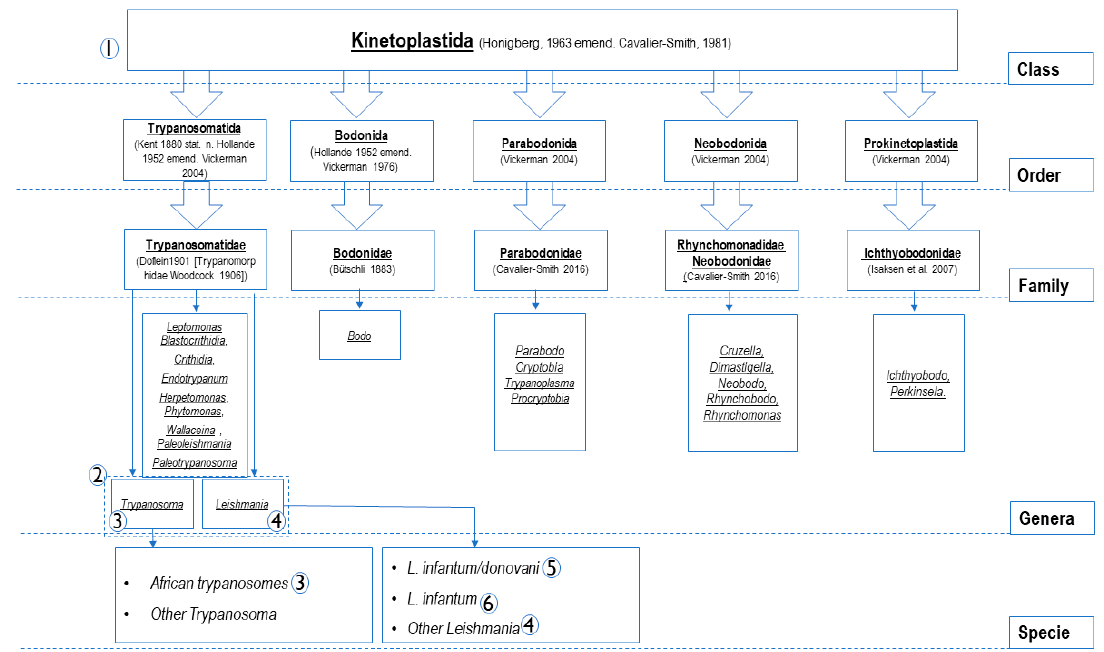
Figure 1. Members belonging to Kinetoplastida class (according to Sina M et al., 2012) [30] and specificity-based principles of the oligonucleotide design. The numbers from 1 to 6 constitute PCRs systems listed in Table 1. As shown in this figure and in the Table 1, PCR systems were designed to amplify the DNA of PCRs ( 1 ): all Kinetoplastida; PCR ( 2 ): Leishmania and Trypanosoma spp.; PCRs